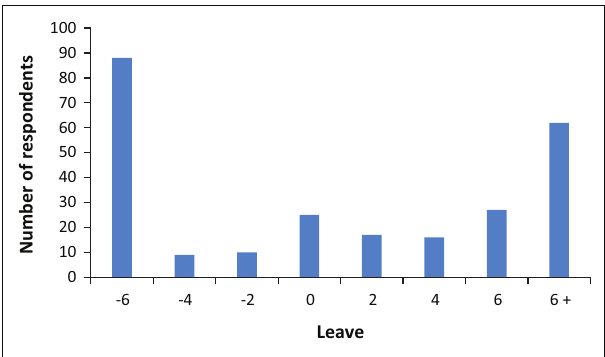
FIGURE 3: Frequency distribution for the level of leave for which an employee would consider moving to another organisation with a perceived strong employer brand.